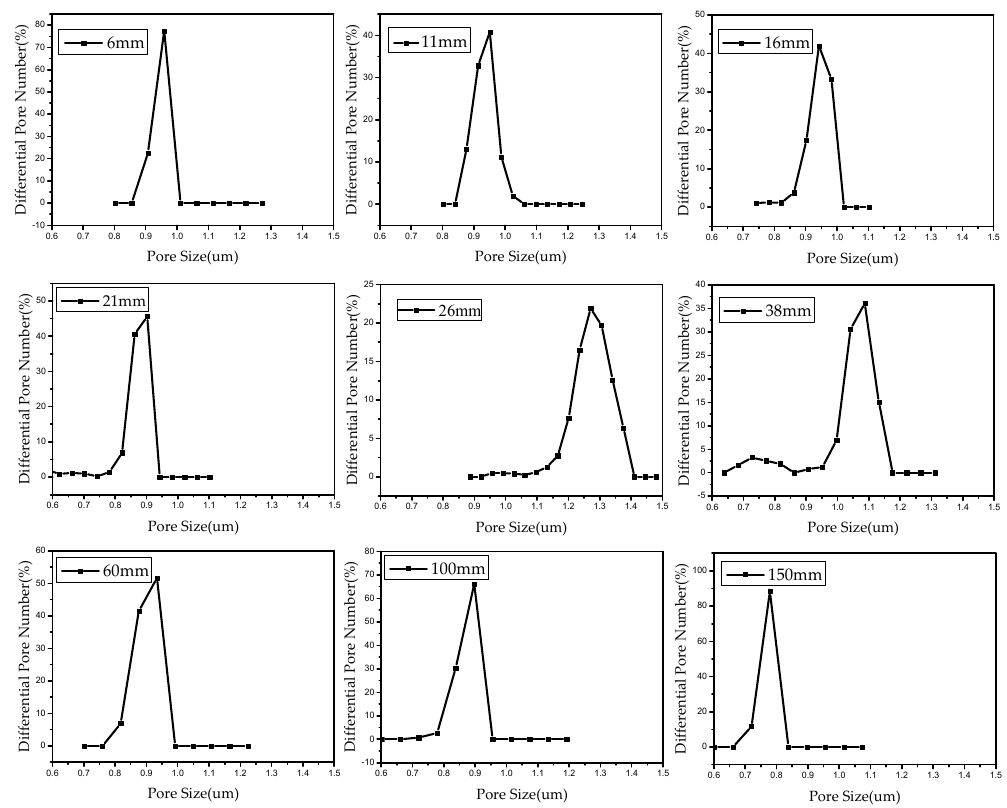
Figure 10. Pore size distributions of PVA membranes prepared by different needles.